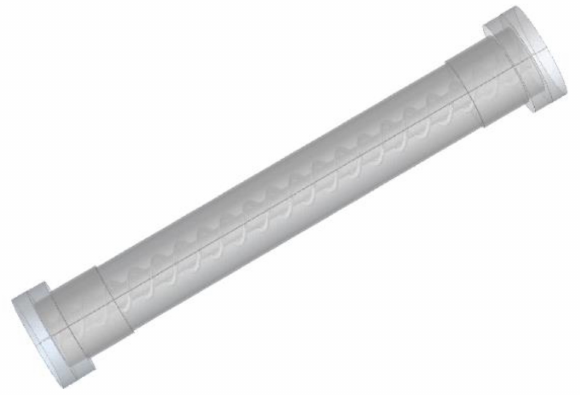
Figure 4. Entity model of direct current (DC) voltage divider.